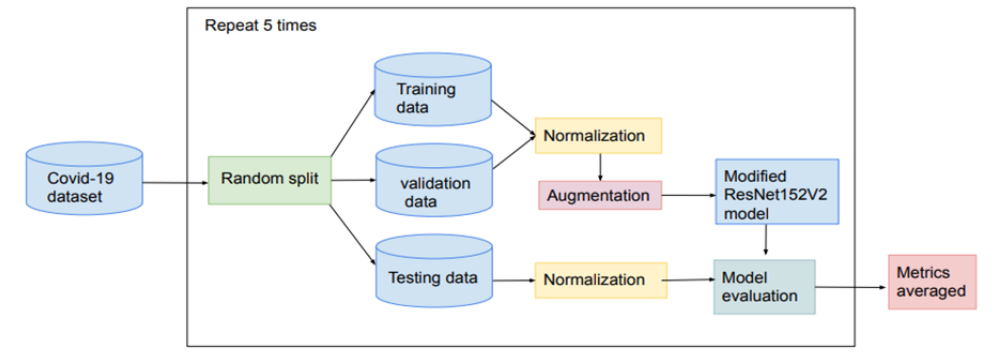
Fig.10 Monte Carlo Cross-Validation with five times